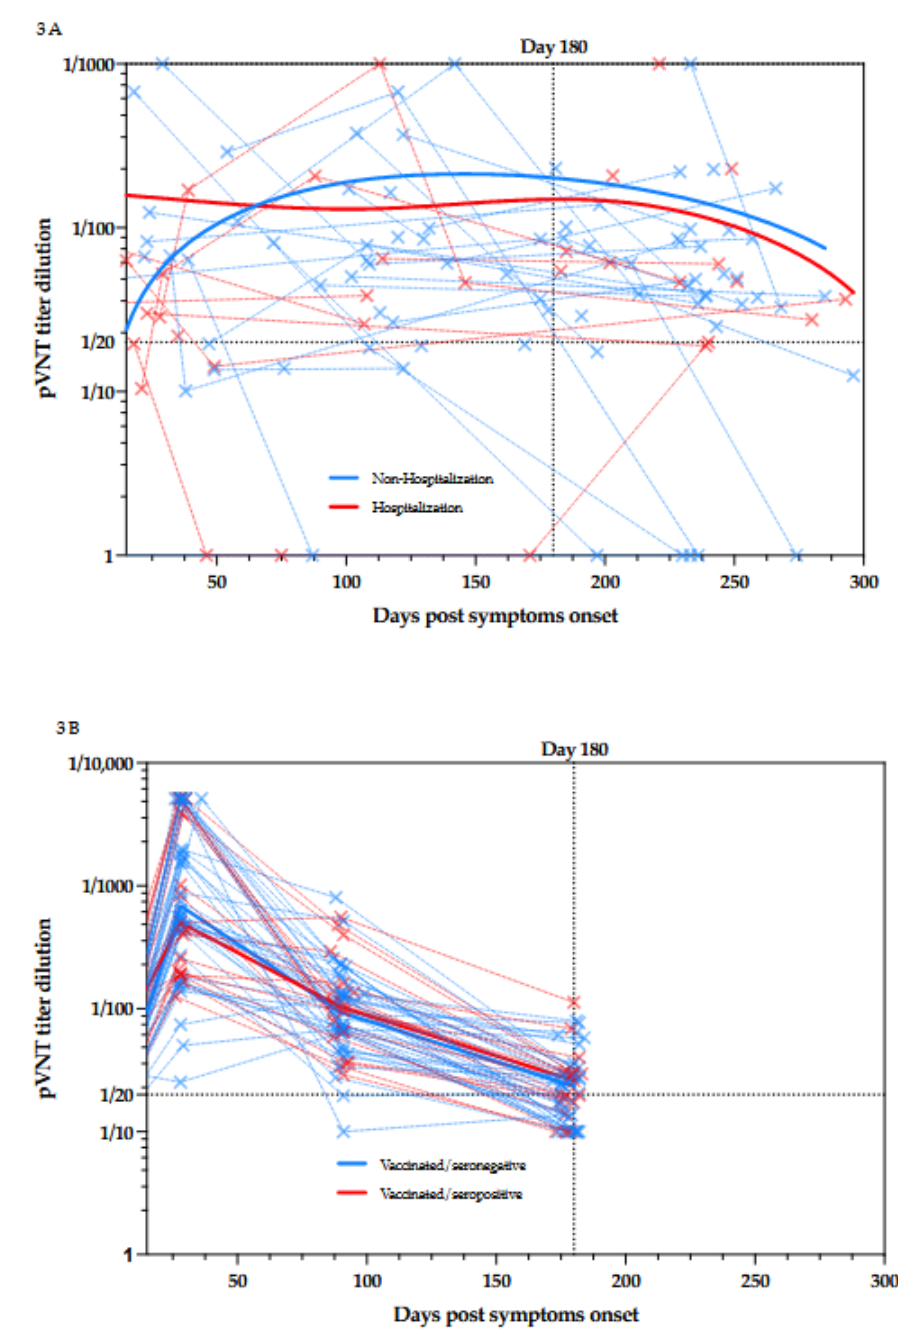
Figure 3. ( A ) Kinetics of NAbs since the symptom onset in non-hospitalized and hospitalized patients. Blue plain lines represent non-hospitalized patients and red plain lines represent hospitalized patients. Samples obtained at different times for the same patient are connected by dotted lines. ( B ) Kinetics of NAbs since the day of first dose vaccination in seronegative and seropositive individuals. Blue plain lines represent seronegative individuals and red plain lines represent seronegative individuals. Samples obtained at different times for the same individual are connected by dotted lines.